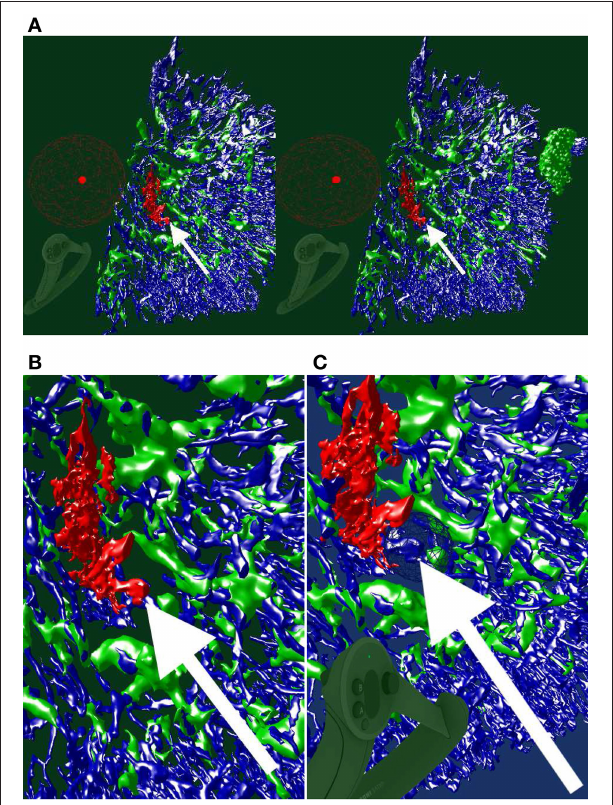
FIGURE 12 | An ongoing session of mesh painting with geodesic distances as VR screenshots. We use the “sinus” data set. (A) Notice the huge annotation ball on the controller, the bright red dot is its center. This center is the starting point of the geodesic computation, initiated by the trigger on the controller. The large radius of the marking tool is bounded by the connectivity: the vertices which are within the radius, but are not connected to the starting point or are “too far” geodesically, are not painted. (B) For better visibility, we show a crop from the left eye view of (A) . The white arrow shows a point of interest. (C) An excessive marking (white arrow), is removed with a repeated painting operation. On the bottom left in (A,C) , a Valve Index controller is visible. The background color in this figure signifies the highlighting mode